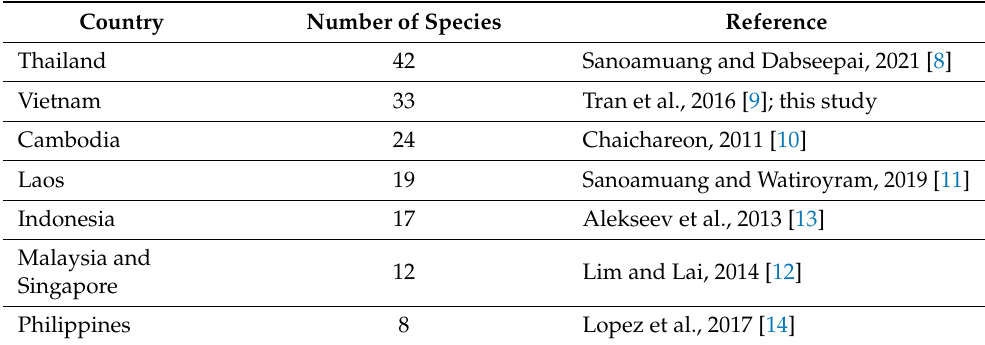
Table 6. The number of diaptomid species found in some Southeast Asian countries. Country Number of Species Reference